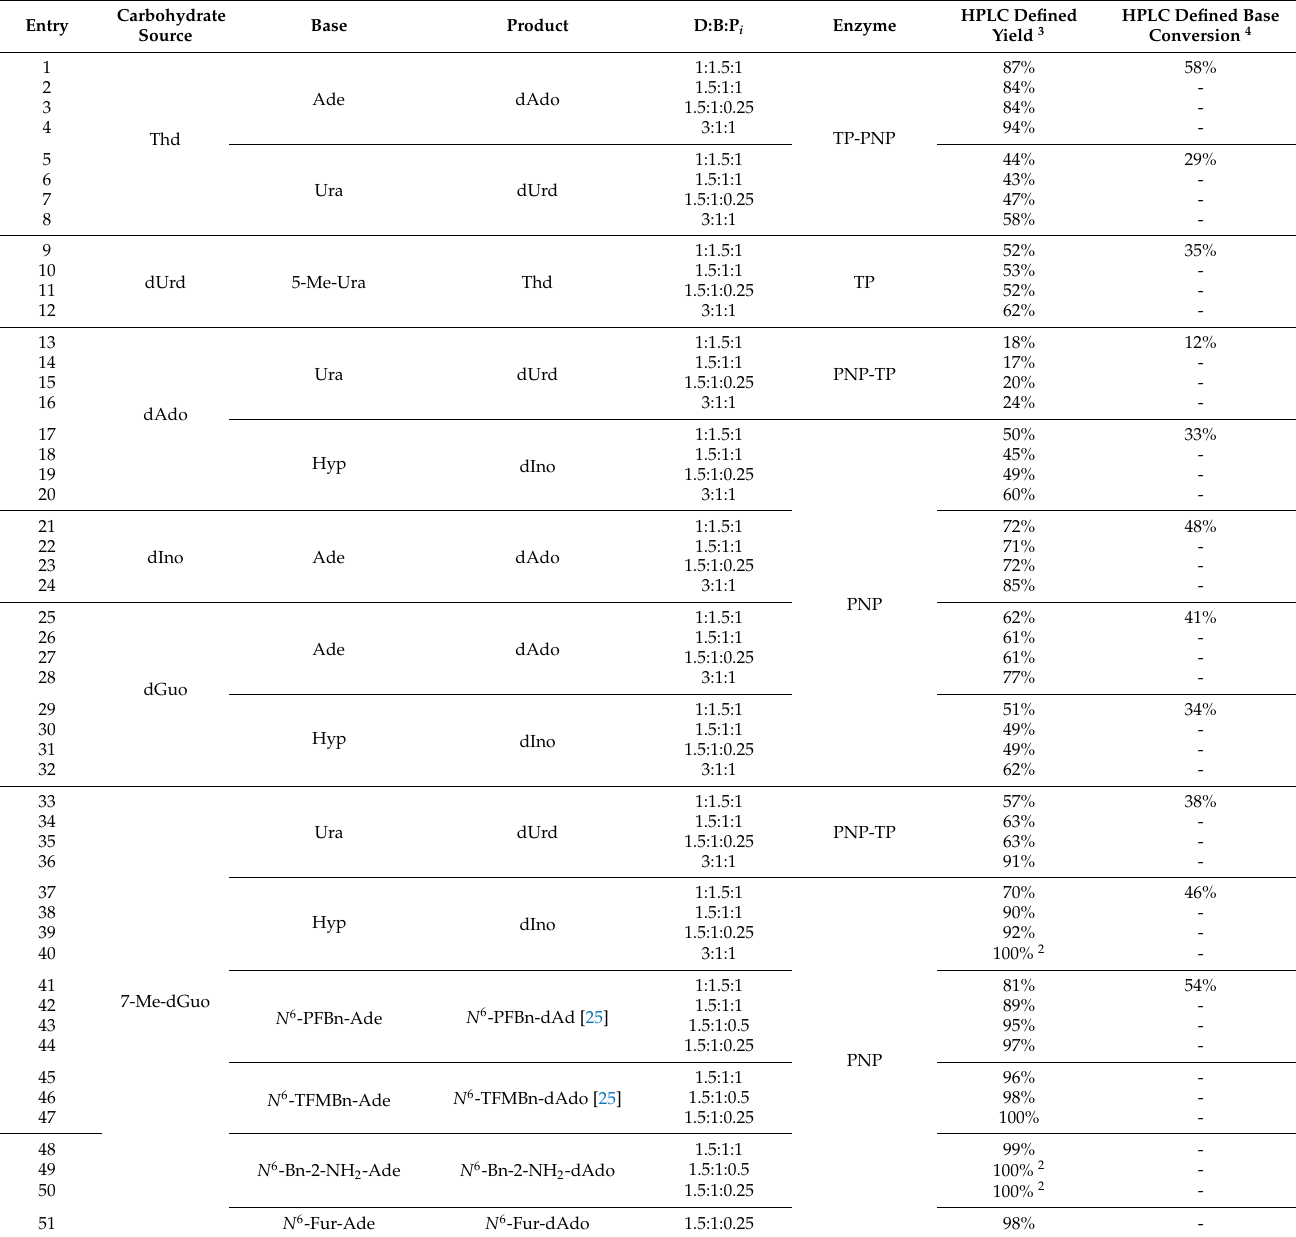
Table 1. Enzymatic synthesis of 2 (cid:48) -deoxynucleosides using NPs 1